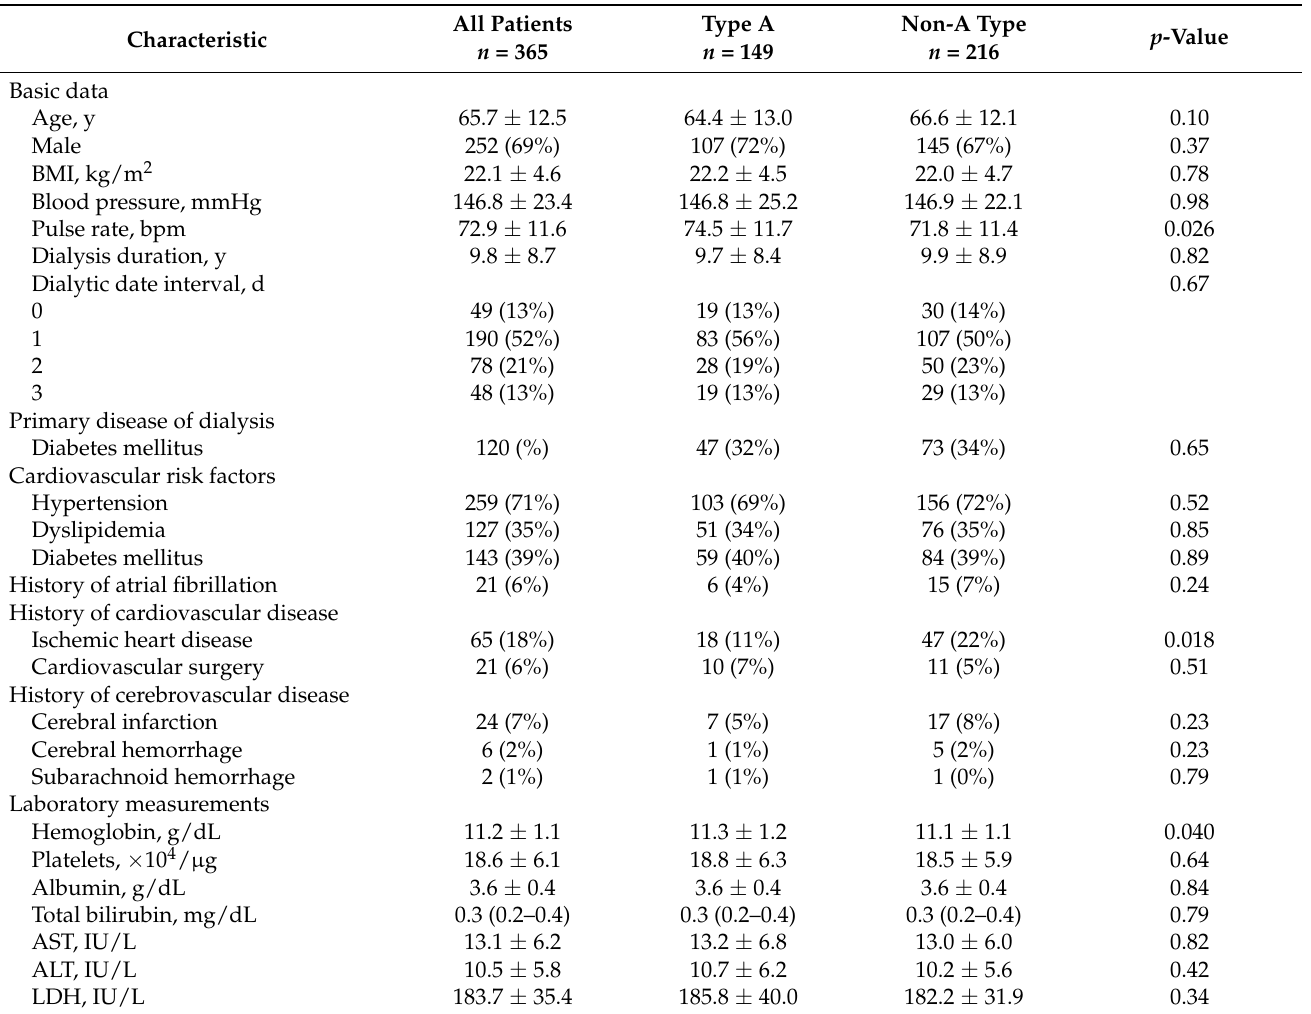
Table 2. Baseline